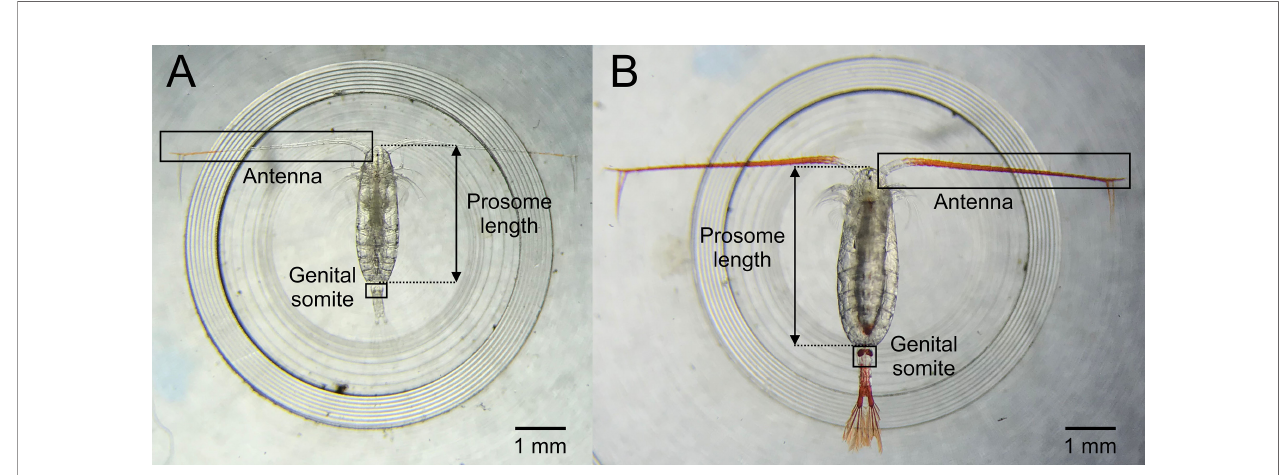
FIGURE 1 | Example images of (A) Calanus fi nmarchicus and (B) Calanus glacialis showing the diagnostic features used (prosome length and redness criteria of antenna and genital somite) to distinguish between females of the two